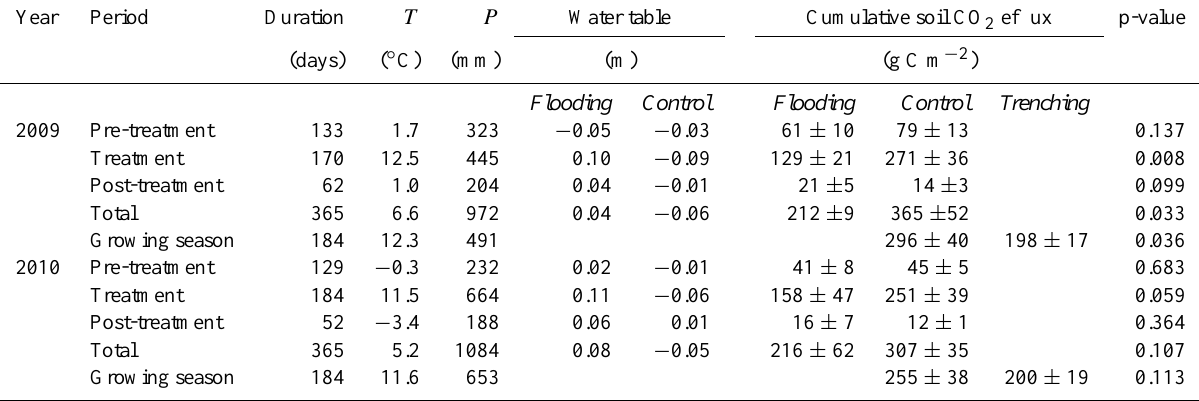
Table 1. Mean air temperature ( T ), sum of precipitation ( P ), mean water table and mean ( ± SD) cumulative soil CO 2 effluxes in the flooded and control plots and in the trenched subplots for different periods in 2009 and 2010. Growing season from 1 May–31 October. P-values indicate the statistical significance between cumulative soil CO 2 effluxes of the treatments for different time periods. Year Period Duration T P Water table Cumulative soil CO 2 efflux p-value